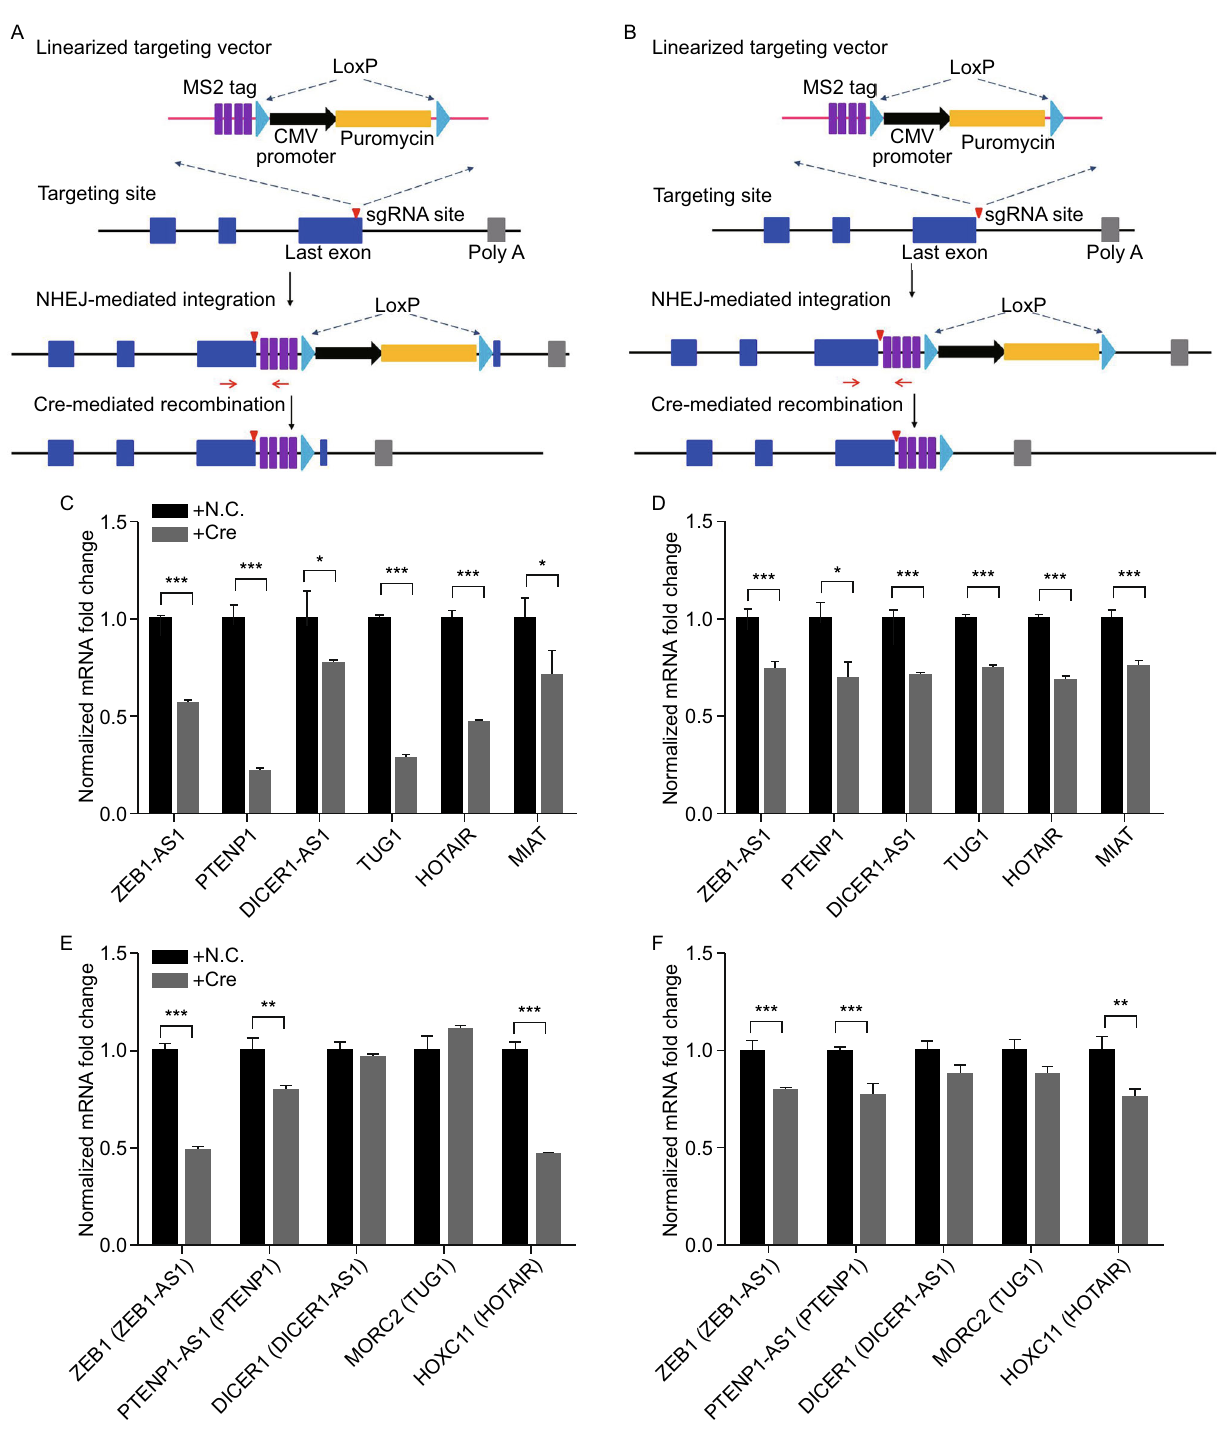
Figure 2. Reversion of targeted insertion near transcriptional termination by Cre-mediated recombination . (A and B) A scheme for CRISPR/Cas9-mediated targeted insertion, which is similar to Fig. 1A; Cre-mediated reversion of targeted insertion is